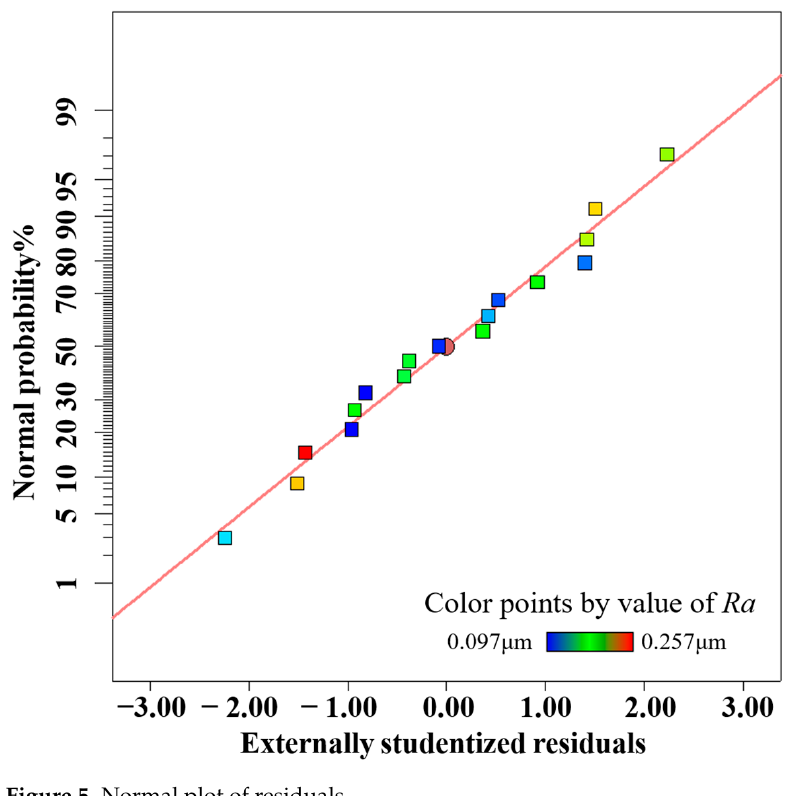
Figure 5. Normal plot of residuals.